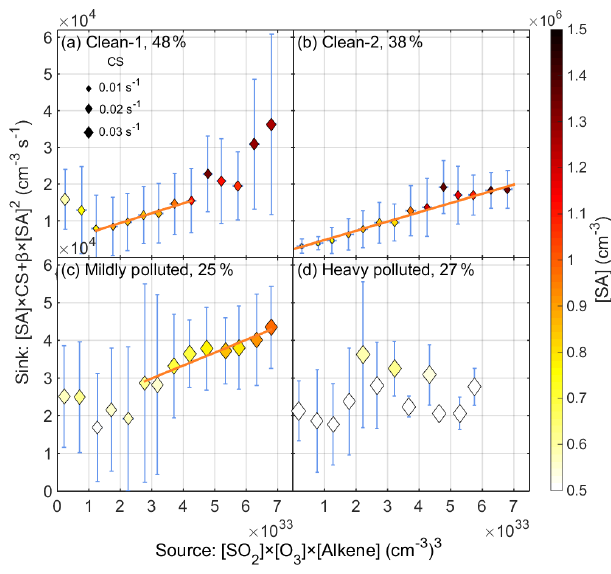
Figure 5. Correlation between the source term ([SO 2 ][O 3 ][Alkene]) and sink term ([SA]CS + β [SA] 2 ) of SA under PSS assumptions during nighttime (20:00–04:00 next day) from 18 January to 15 March 2019 for (a) Clean-1 conditions, (b) Clean-2 conditions, (c) mildly polluted conditions and (d) heav- ily polluted conditions. Note that the data points are mean values of corresponding bin ranges instead of the original, high-time- resolution data (Fig. S5). The error bars are the standard deviation of all data points in each